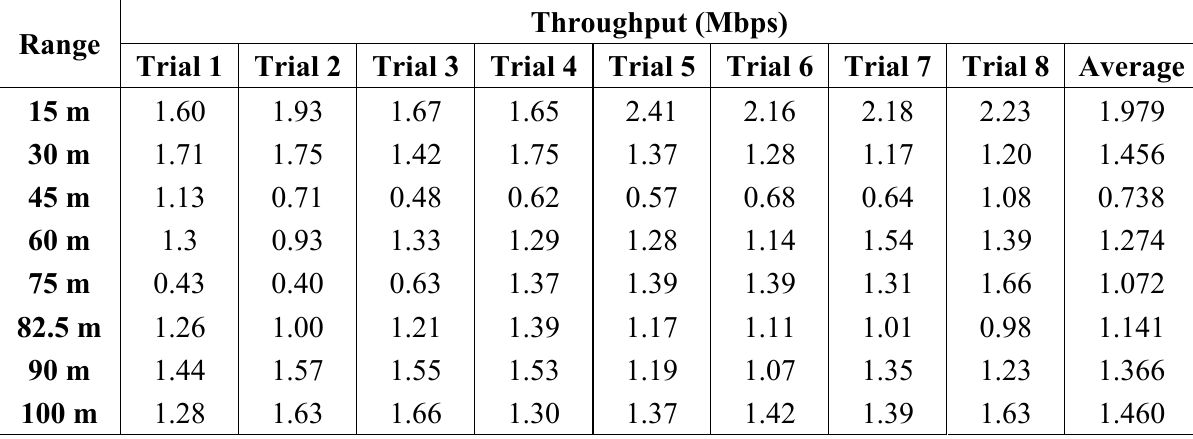
Table 2. The bandwidth results for the station 1–station 2 connection that uses the same channel for both the mesh and AP interfaces.